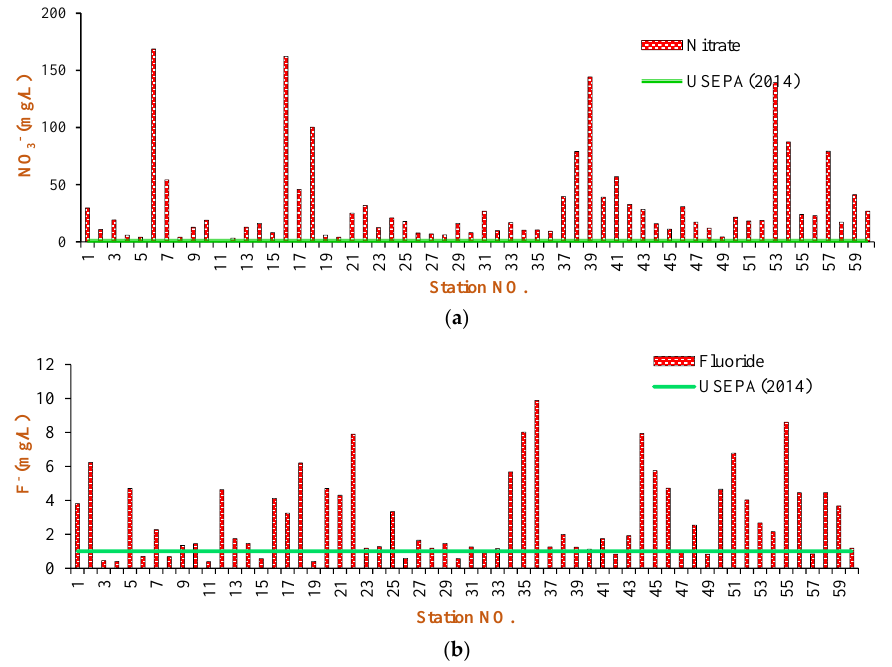
Figure 5. Excessive contaminants (non-carcinogenic) at the sampled water resources (( a ): Nitrate; ( b ): Fluoride) [33]. F − concentrations are often relative to the level of water – rock contact because F − mainly originates from geology [41,42]. The study region is primarily occupied by basalts, which contain a large amount of F − -bearing minerals [43]. The F − concentration likely in- creased because of this in the study area. Compared to NO 3 − contamination, F − contami- nation was highly severe in the study area. The NO 3 − concentration in the Maku – Ba-